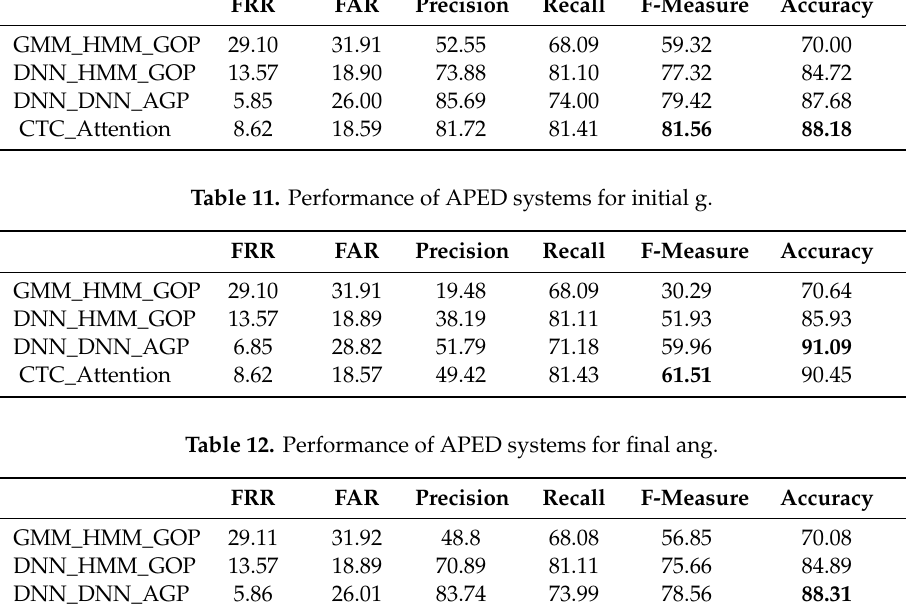
Table 10. Performance of APED systems for initial zh. FAR Recall